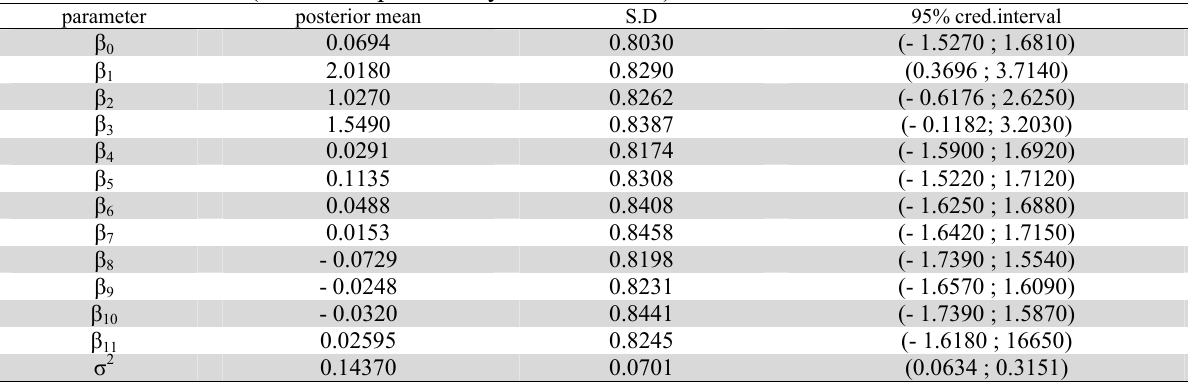
Posterior summaries (use for empirical Bayesian methods) parameter posterior mean